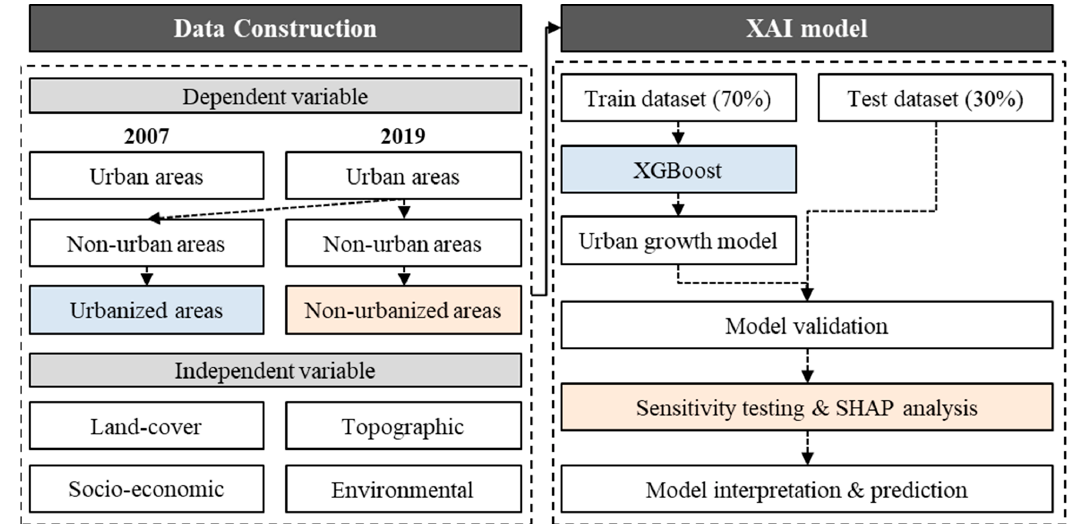
Figure 4. Research